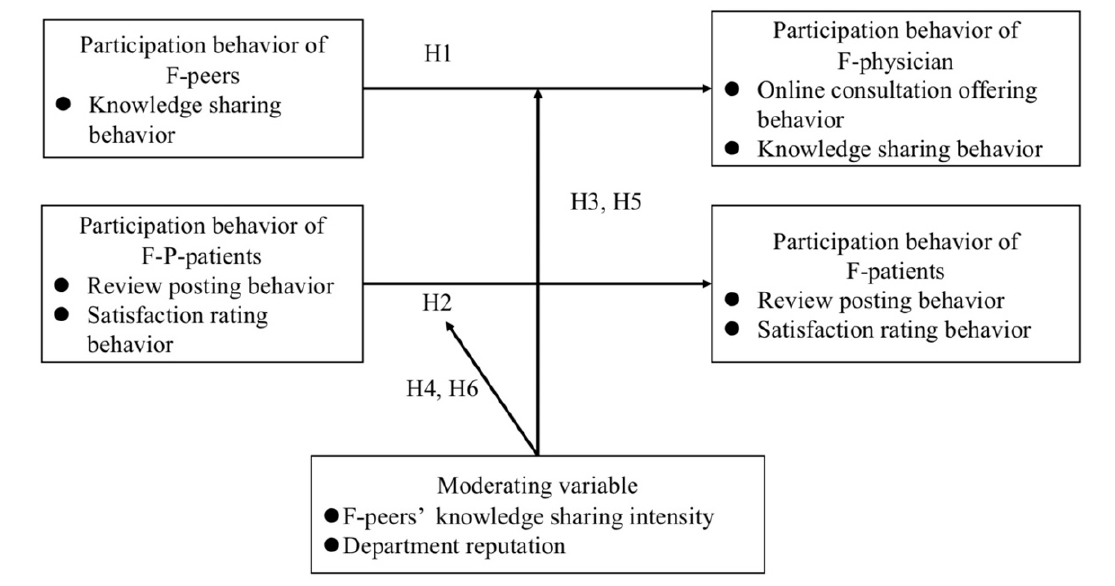
Figure 2. Conceptual model.